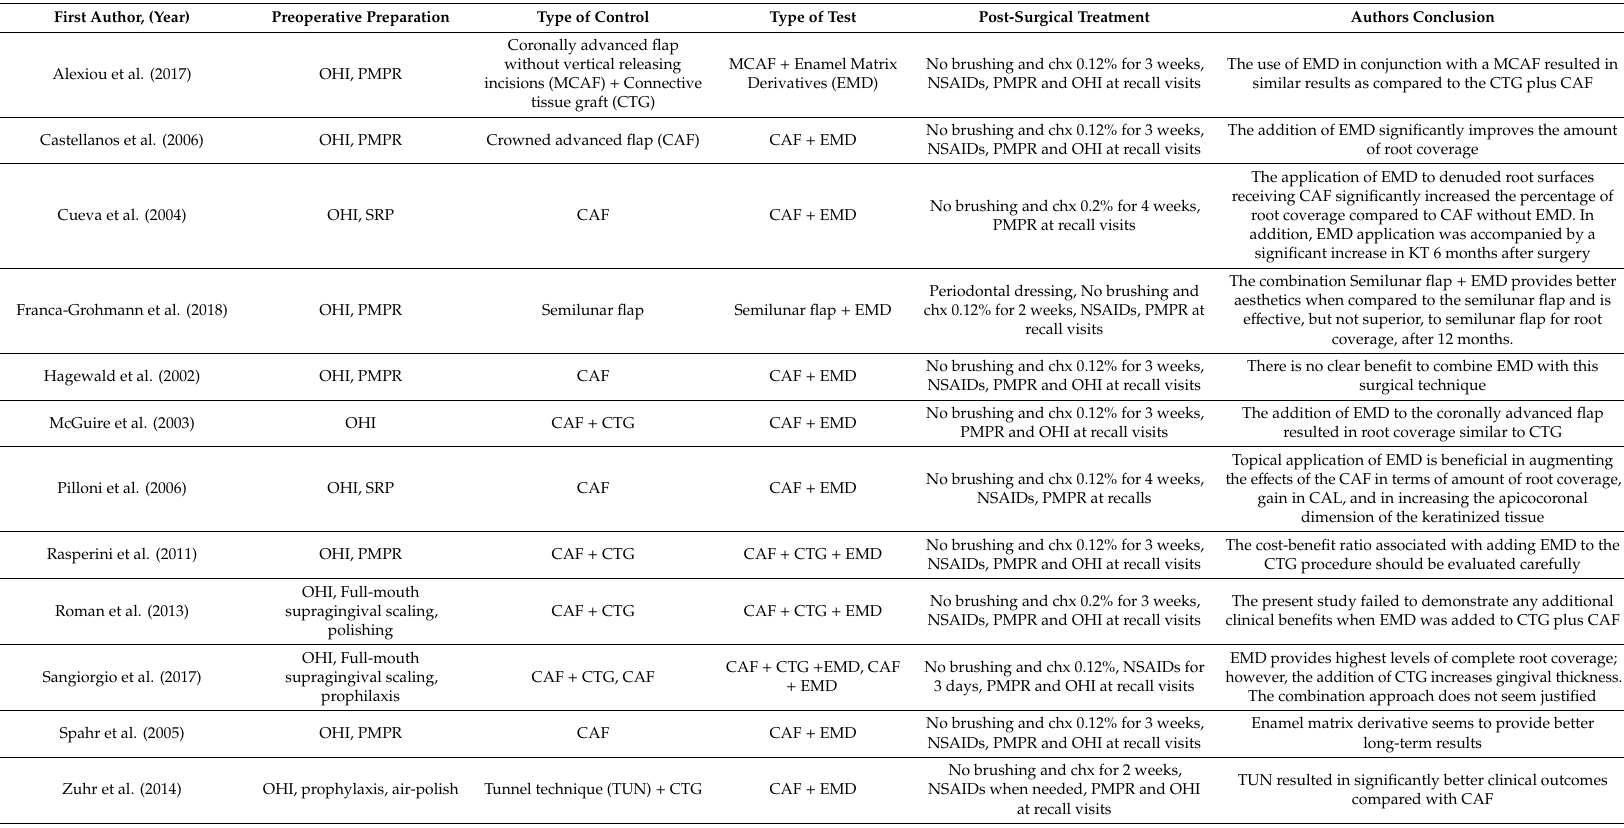
Table 2. General characteristics of